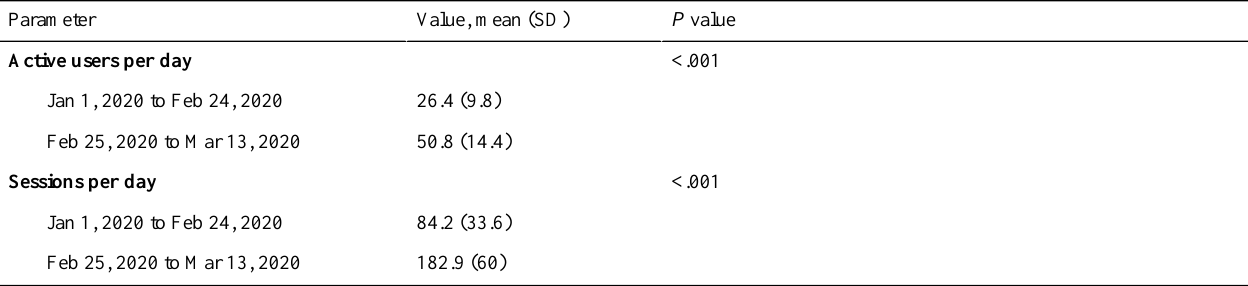
Table 2. User activity on the mobile platform during the SARS-CoV-2